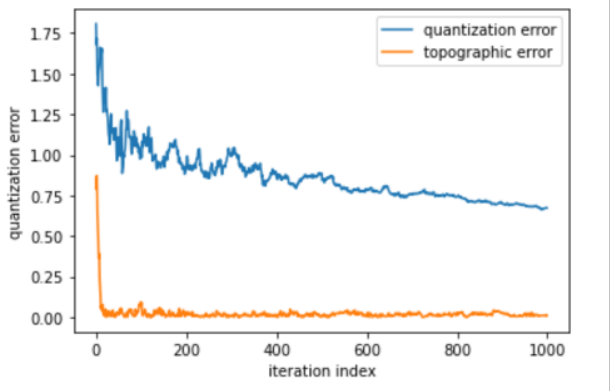
Figure 6. Iterations